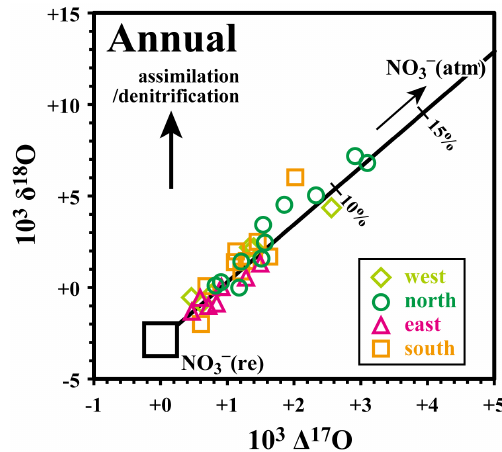
Figure 6. Relationship of the annual average values of (cid:49) 17 O and δ 18 O of NO − in the inflow streams. The symbols represent the lo- 3 cation of each river (west: yellowish green diamonds; north: green circles; east: red triangles; south: orange squares). A hypothetical mixing line between atmospheric nitrate (NO − (atm)) and reminer- 3 alised nitrate (NO − (re)) is shown together with the end-member 3 value of NO − (re) (large white square) and the 10 and 15% mole 3 fractions of NO − (atm) on the line. The errors were smaller than the 3 sizes of the